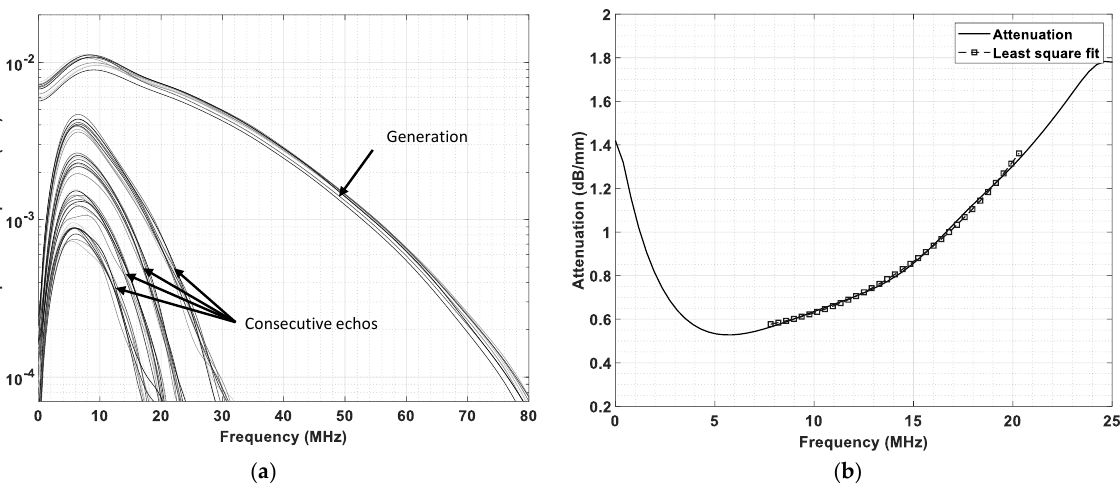
Figure 3. ( a ) Plot of frequency content in the generation event and the consecutive echoes from the A-scans shown in Figure 2. ( b ) The calculated attenuation as a function of frequency (solid black line) for the 2nd backwall echo of one of the A − scans in ( a ), The fitted 3rd-order attenuation (dashed line with square markers) is also plotted. The fitting is only performed in the region where the SNR sufficiently large and the frequencies are high enough for the diffraction to be negligible.